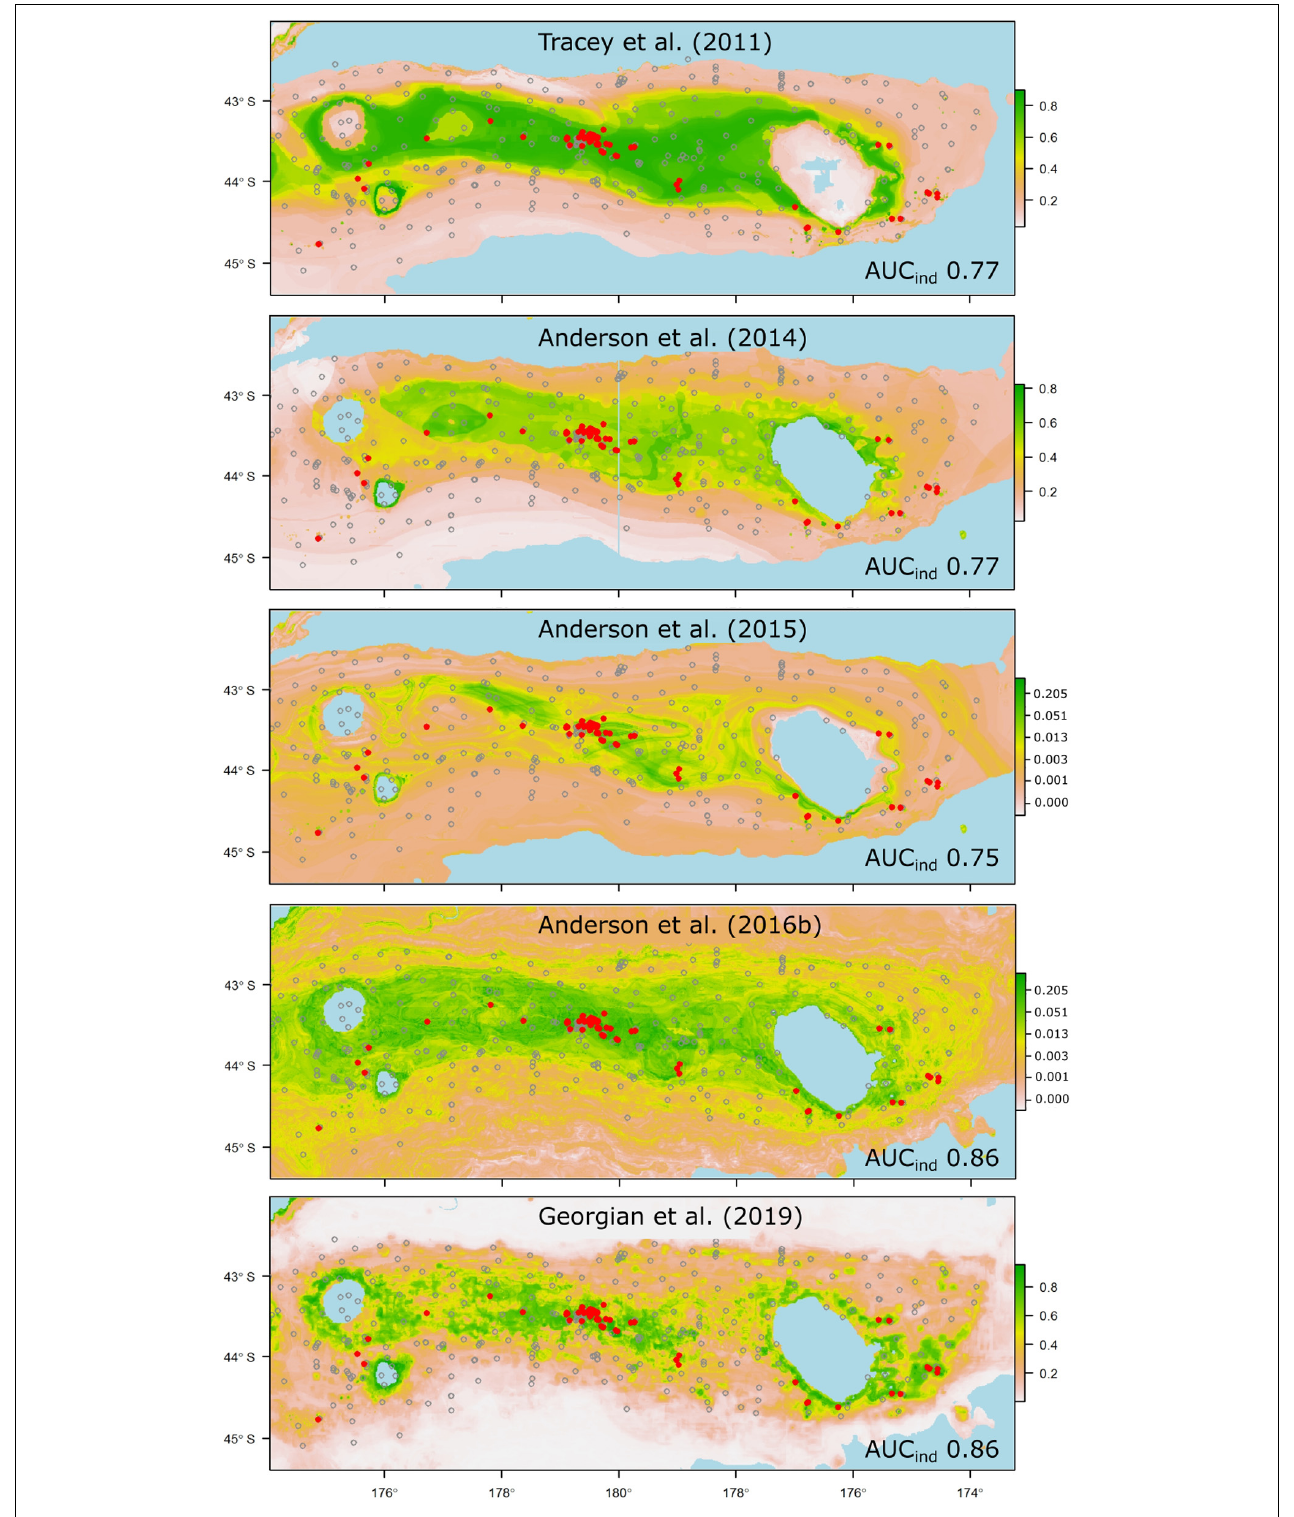
FIGURE 5 | Probability of suitable habitat for the branching scleractinian coral Goniocorella dumosa on Chatham Rise, as predicted by habitat-suitability models in five published studies. Probability values are scaled at right, and prediction maps are overlaid with presence (red dots) and absence (gray circles) locations from the independent photographic observation dataset. AUC values from testing against the independent dataset are shown for each model (AUC ind ).